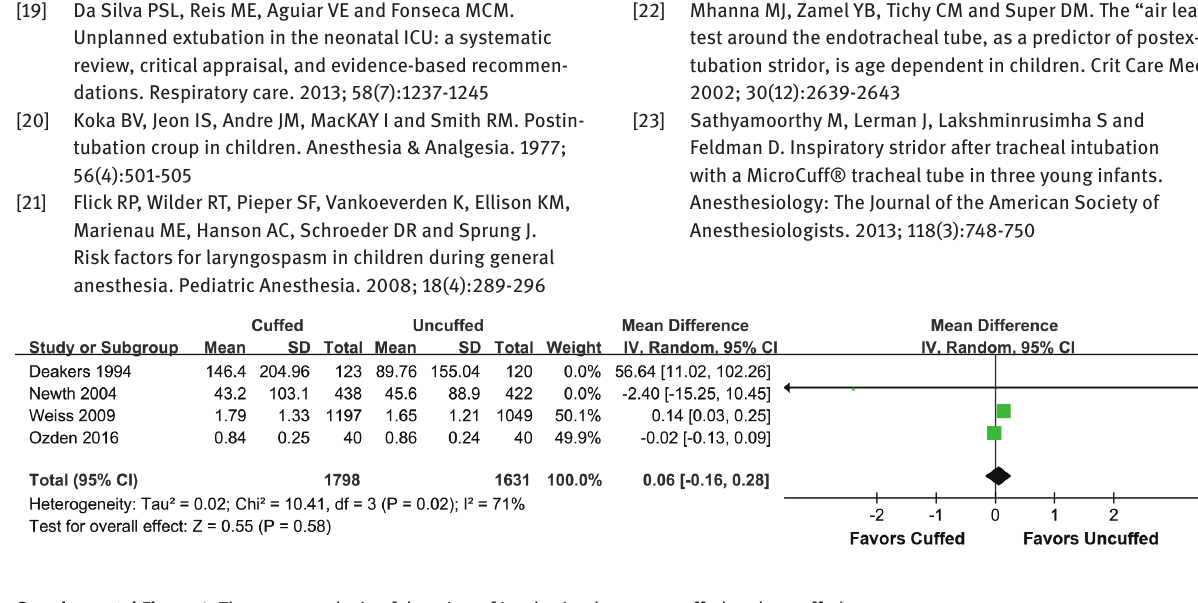
Supplemental Figure 1: The meta-analysis of duration of intubation between cuffed and uncuffed groups.